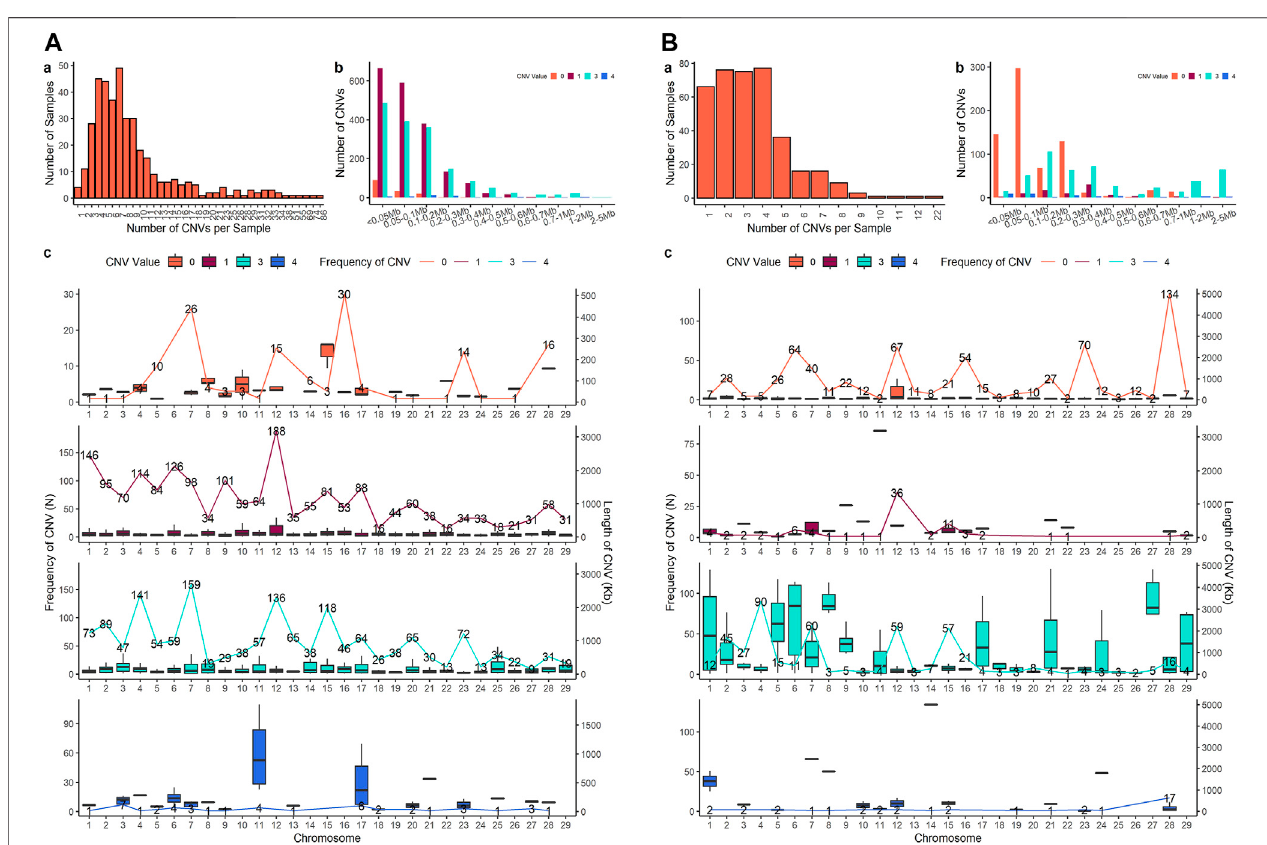
FIGURE 2 | (CNVs) summary plot. (A) The results of the Penn-ARS version. (B) The results of the Part-ARS version. In each panel, a shows the total number of CNVsineachindividualthatweredetected;bshowsthefrequencyofcopiesofCNVsindifferentlengthgroups;cshowsCNVsstatesanddistributiononchromosomes. The lines indicate the quantity of CNVs, bar plot presents the length distribution.